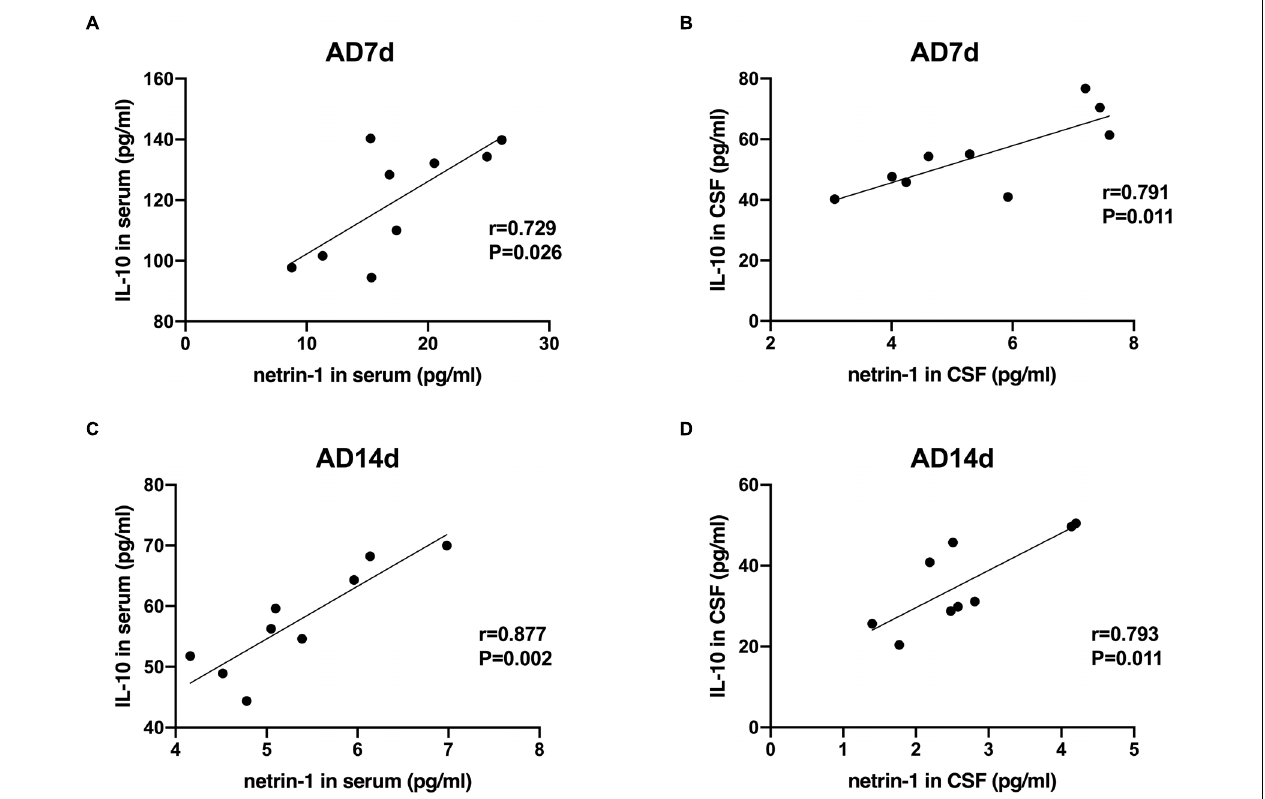
FIGURE 9 | Positive correlations between netrin-1 and IL-10 concentrations in the serum and CSF of AD rats. Positive correlations were obtained between serum netrin-1 and IL-10 concentrations in the AD7d (A) and AD14d (C) groups. Positive correlations were obtained between CSF netrin-1 and IL-10 concentrations in the AD7d (B) and AD14d (D)